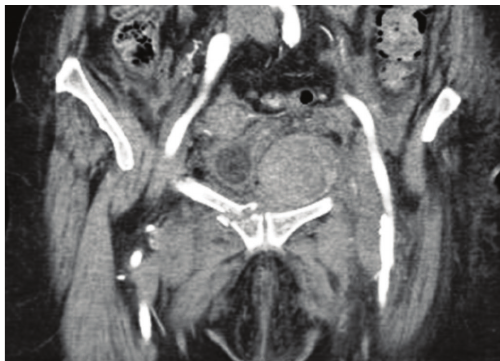
Figure 2: Coronal CT of the pelvis showing left haematoma neighboring the right fractured iliopubic